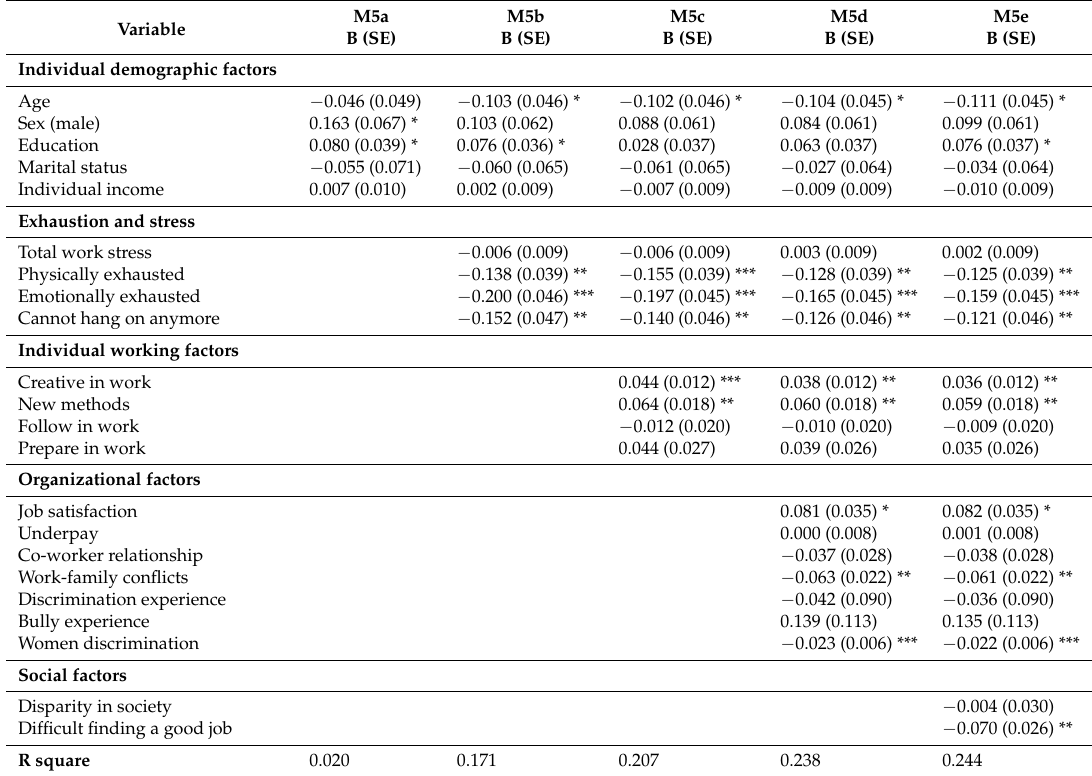
Table 4. Self-rated health of workers and association with work stress and exhaustion by linear